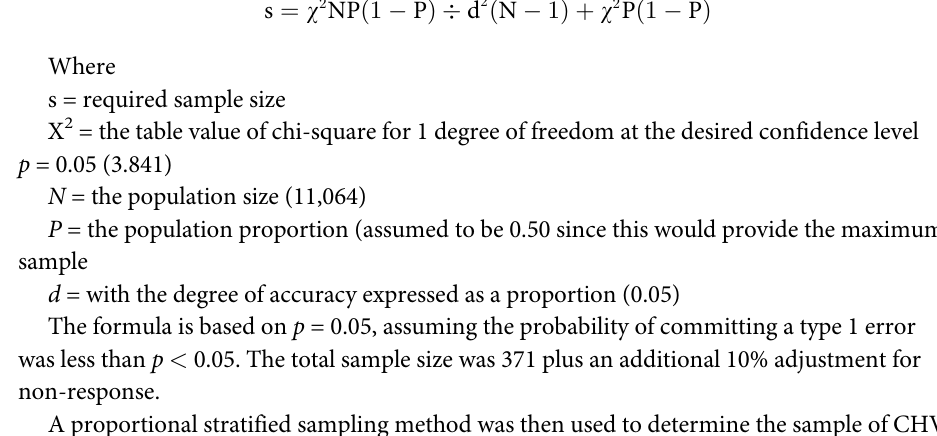
X 2 = the table value of chi-square for 1 degree of freedom at the desired confidence level p = 0.05